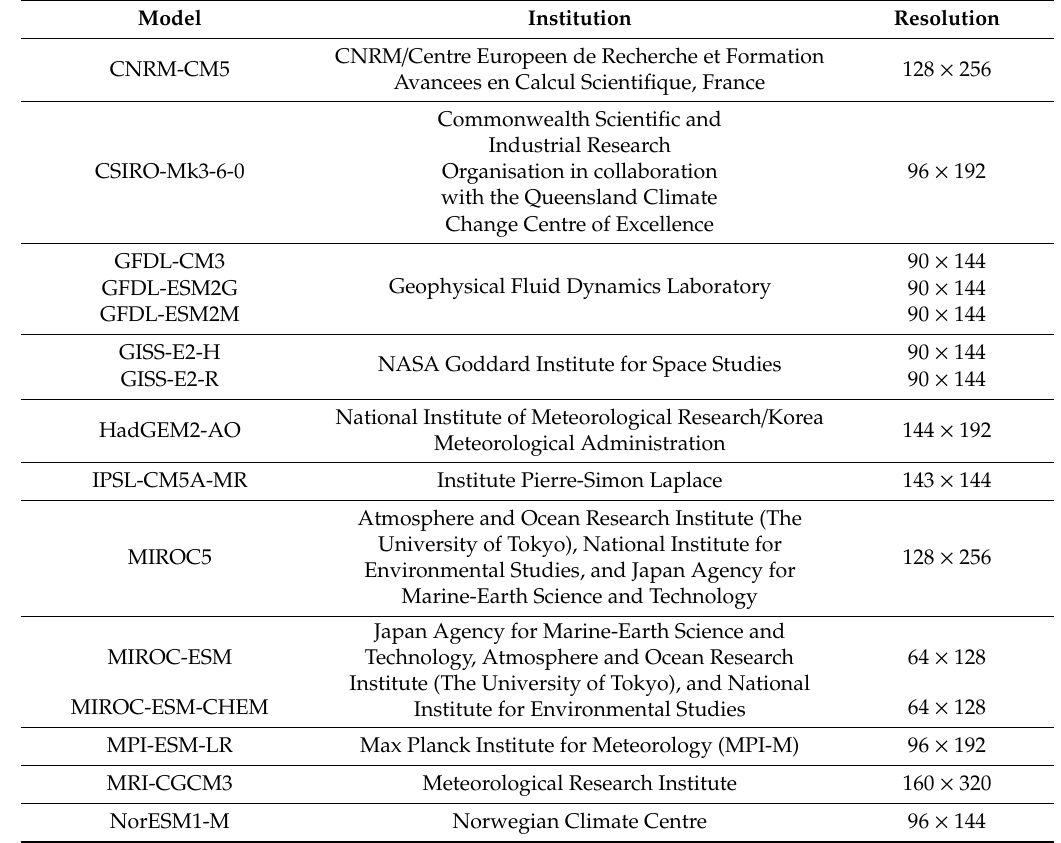
Table 2. Information of 15 global coupled climate